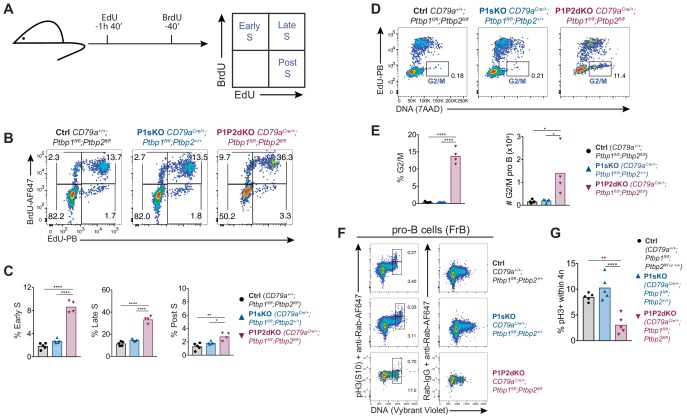
Enhanced entry into S-phase and block at G2 in P1P2dKO pro-B cells.(A) EdU and BrdU sequential labelling experimental set up to distinguish early, late and post S-phase cells. (B) Flow cytometry data of the different stages of S-phase in pro-B cells (B220+CD19+IgD-surfaceIgM-intracellular-Igμ-CD43high) identified as shown in Figure 6—figure supplement 2A. Numbers shown are proportions of cells. (C) Percentages of pro-B cells in different S-phase stages determined as shown in A and B. (D) Flow cytometry data of pro-B cells identified as shown in Figure 6—figure supplement 2A and excluding BrdU+-only (cells in early S-phase). Numbers shown are proportions of cells in the G2/M gate. (E) Proportions and numbers (in 2 femurs and two tibias per mouse) of pro-B cells in G2/M identified as shown in (D). (F) Phospho-histone 3 serine 10 (pH3 S10) staining amongst FrB pro-B cells identified as in Figure 6—figure supplement 1A. (G) Percentages of pH3(S10)-positive cells amongst cells with 4N DNA amounts in pro-B cells (FrB) assessed by flow cytometry as shown in F. (C, E, G) Bars depict arithmetic means, each point represents data from an individual mouse and P-values were calculated by one-way ANOVA with Tukey's multiple comparisons test. Summary adjusted p-value *<0.05, **<0.01, ***<0.001, ****<0.0001. (B–E) Data shown are from one of two independent experiments. (F, G) Data shown are from one out of three independent experiments.